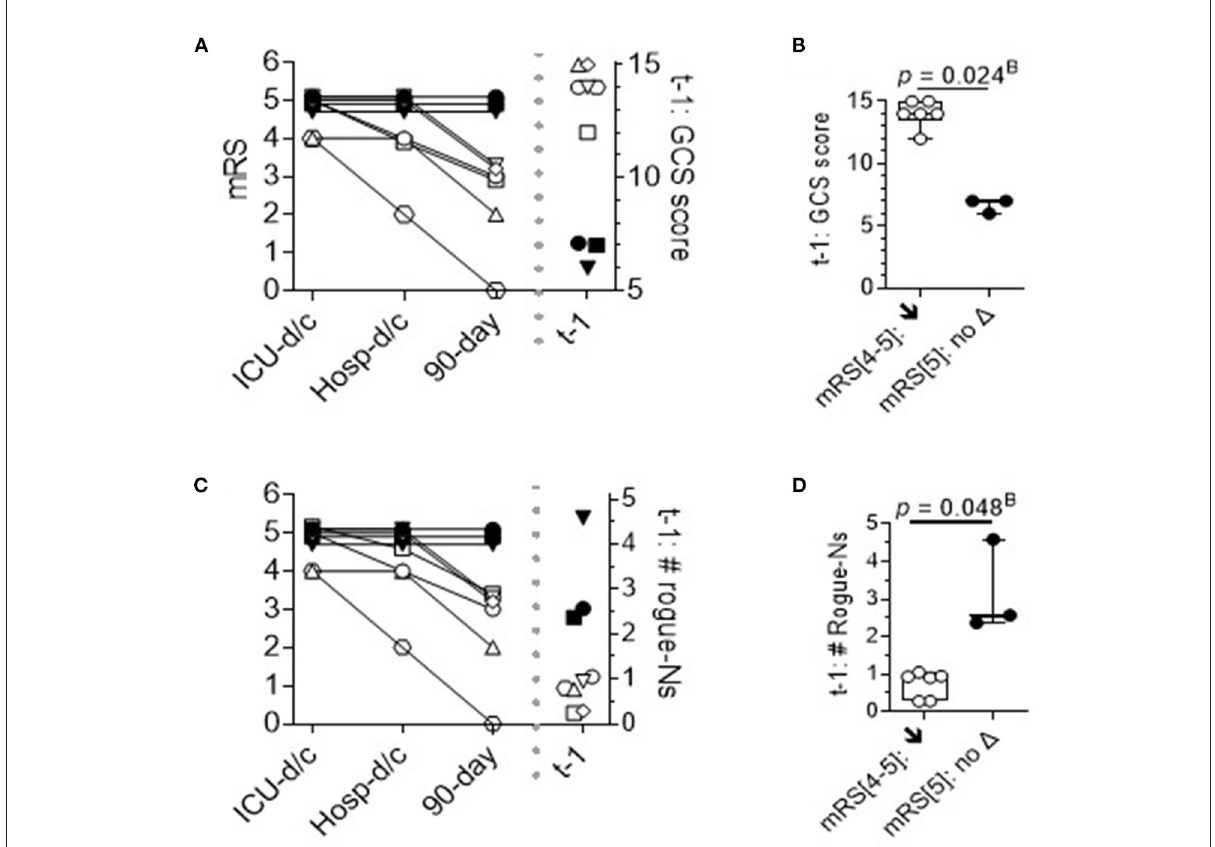
FIGURE5 Time course of modified Rankin Scale (mRS) scores in sICH survivors. Per patient time course of mRS at discharge from the ICU, discharge from the hospital, and 90 days from sICH diagnosis: survivors ( n = 9), stratified by no improvement ( H(cid:4) • ) vs. 90-day improvement in mRS ( n = 6: (cid:13) △ ▽ (cid:3)♦ * ). (A) Per patient mRS plot and corresponding GCS scores on the day of flow cytometry analysis. Stratification of survivors with improvement ( ↓ ) vs. without improvement (no 1 ) in mRS scores. (B) t-1 GCS scores: 2-tailed Mann-Whitney rank test p = 0.024 B